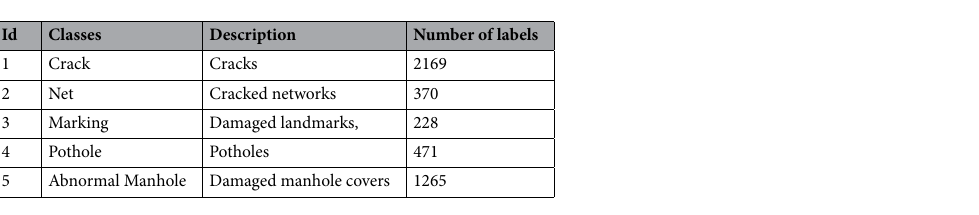
Figure 1. Datasets of pavement distresses under different conditions. ( a ) Crack ( b ) The cracked networks ( c ) Damaged landmarks ( d ) Pothole ( e ) Damaged manhole covers ( f ) The complete pavement under the shaded part.